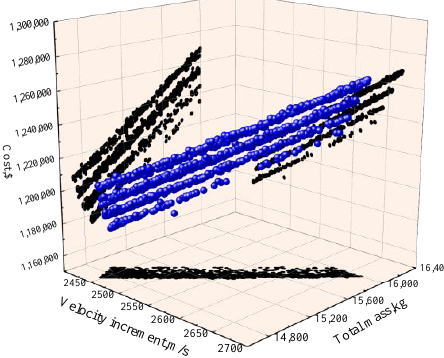
Figure 9. Pareto solution set of HRM-TGPF.